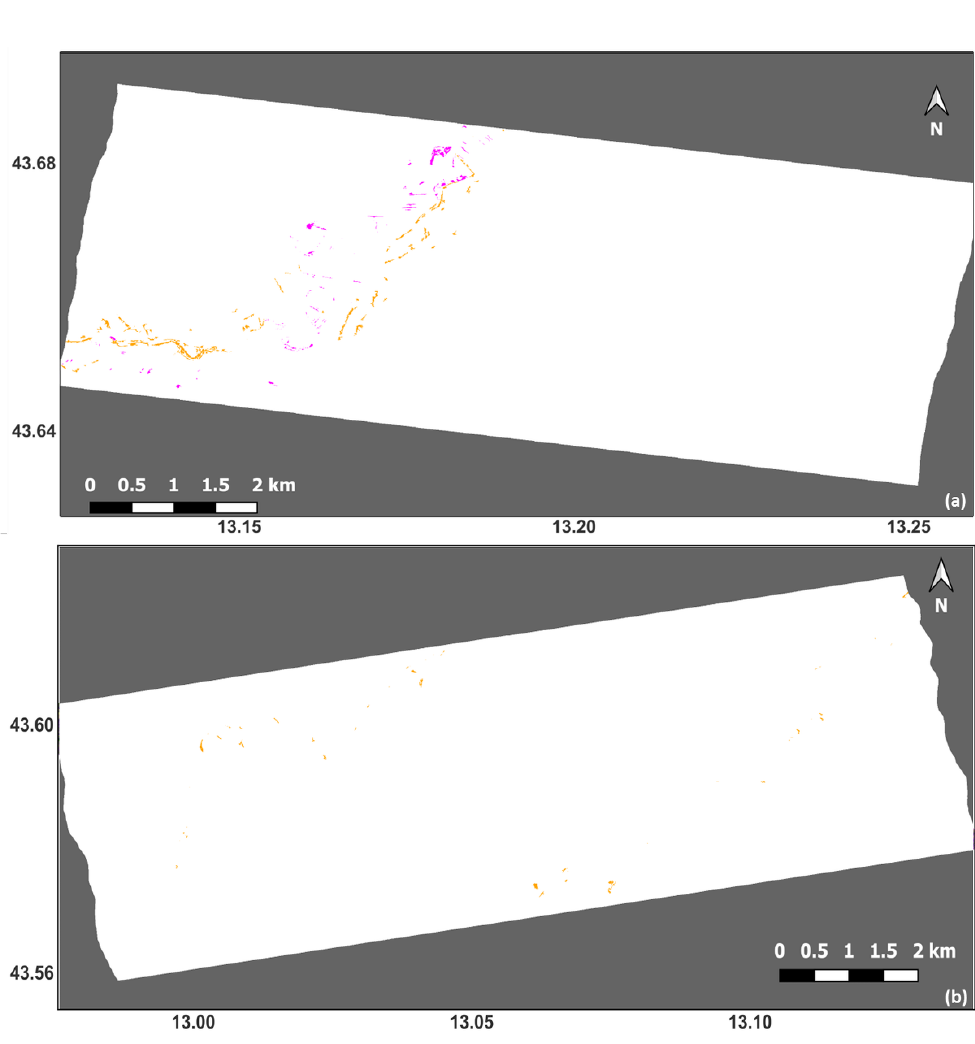
Figure 9. Maps of false positives (orange) and false negatives (magenta) obtained for Brugnetto area ( a ) and Ostra Vetere area ( b ) by comparing the maps shown in Figure 8 with the CEMS products.